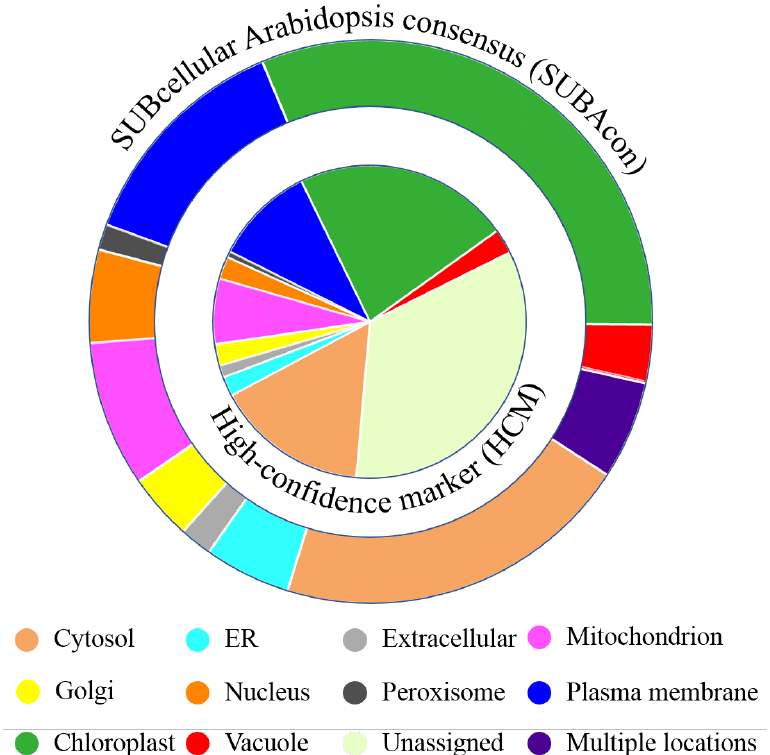
Figure 4. Percentage of the number of distinct proteins for each compartment by (inner pie chart) high-confidence markers (HCM) assignment and (outer pie chart) SUBcellular Arabidopsis consensus (SUBAcon) predictions.